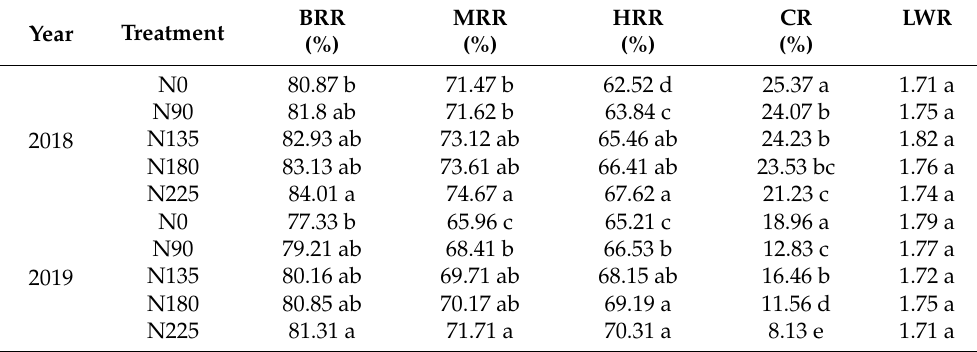
Table 4. Effects of different nitrogen application amount on processing quality of